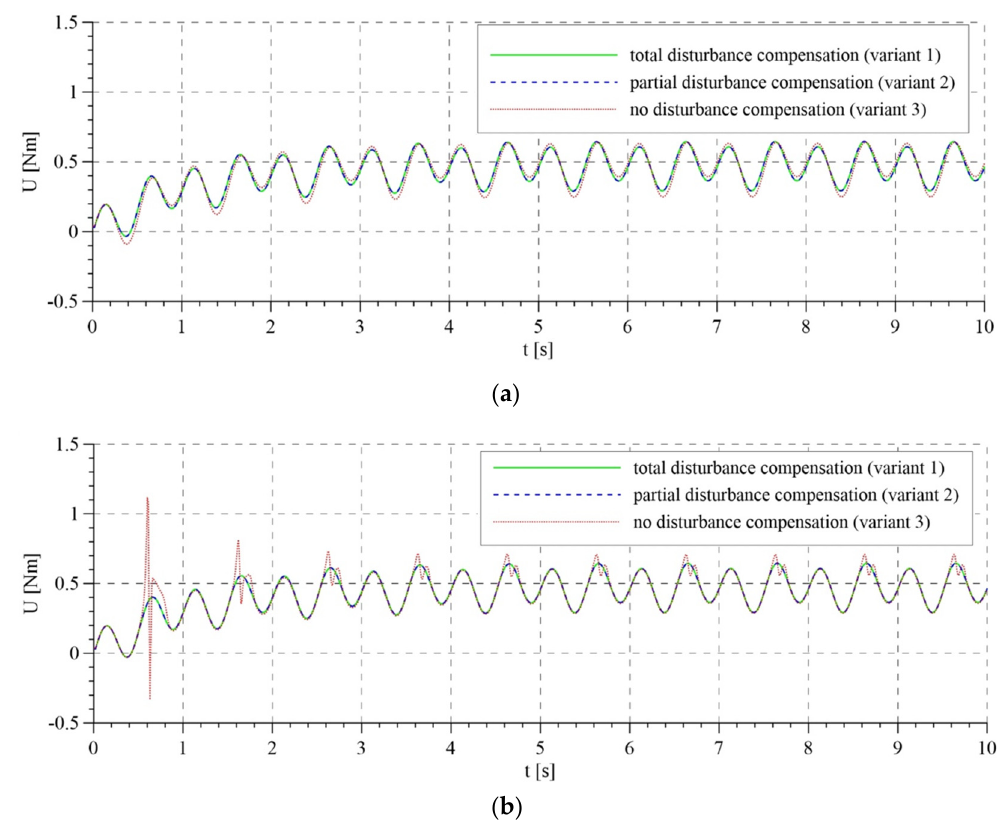
Figure 7. Overall control: ( a ) for the algorithm based on the mathematical model; ( b ) for the adaptive algorithm.